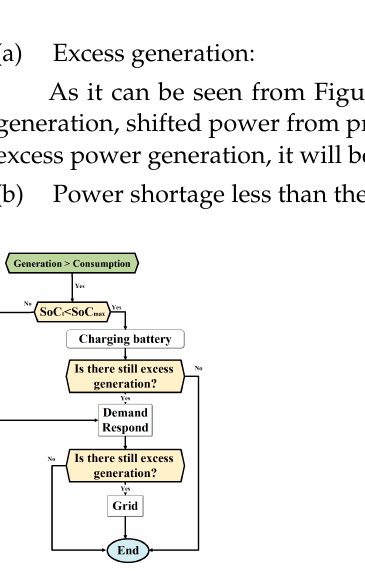
Figure 3. The algorithm of excess section.